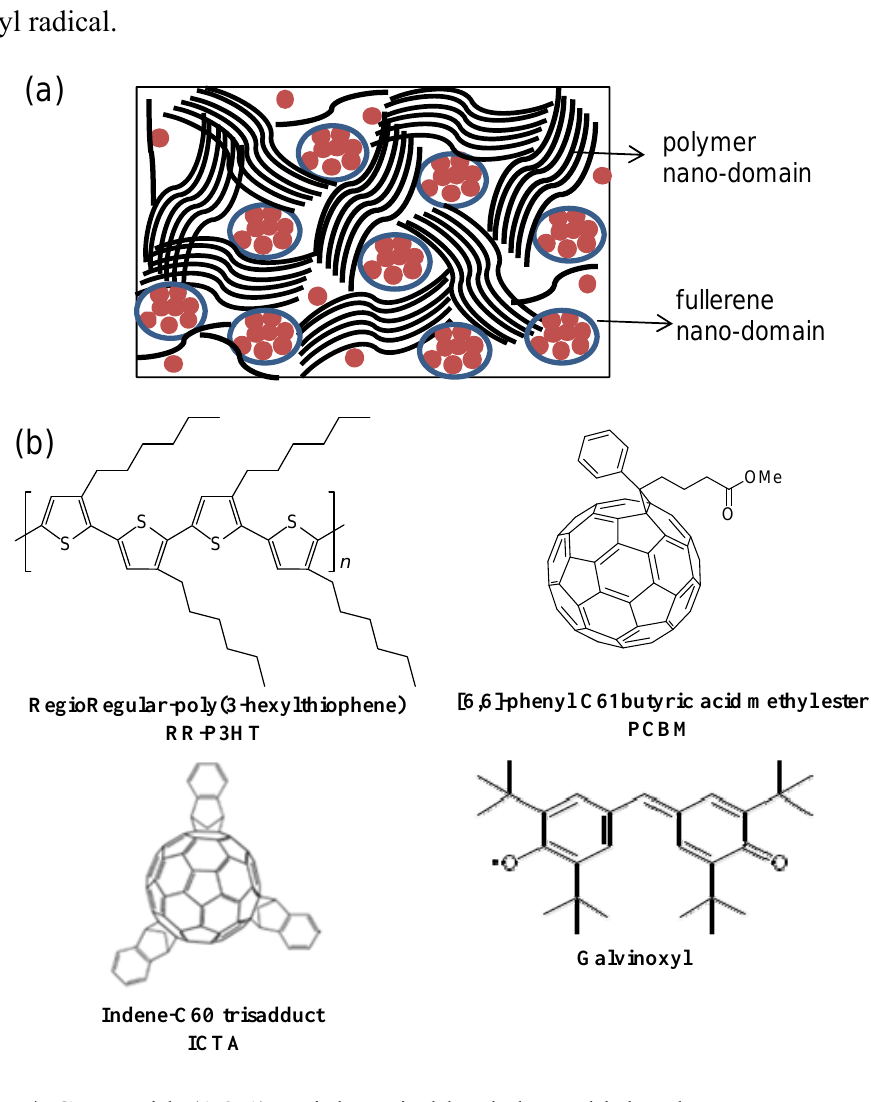
Figure 1. (color on line) ( a ) Schematic diagram of nano-domains of polymer (donor) and fullerene (acceptor) depicted in bulk heterojunction organic photovoltaic blend; ( b ) Schematic molecular structures of the Regio Regular (RR)-P3HT polymer, 6,6-phenyl-C -butyric acid methyl ester (PCBM), Indene C60 trisadduct (ICTA) and 61 Galvinoxyl radical.